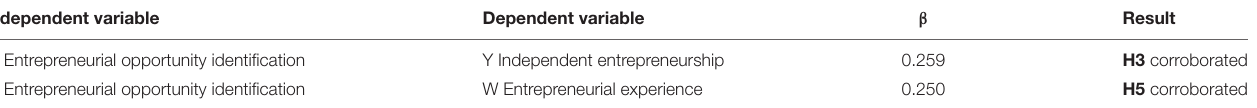
TABLE 8 | Parameters for moderated effect test.